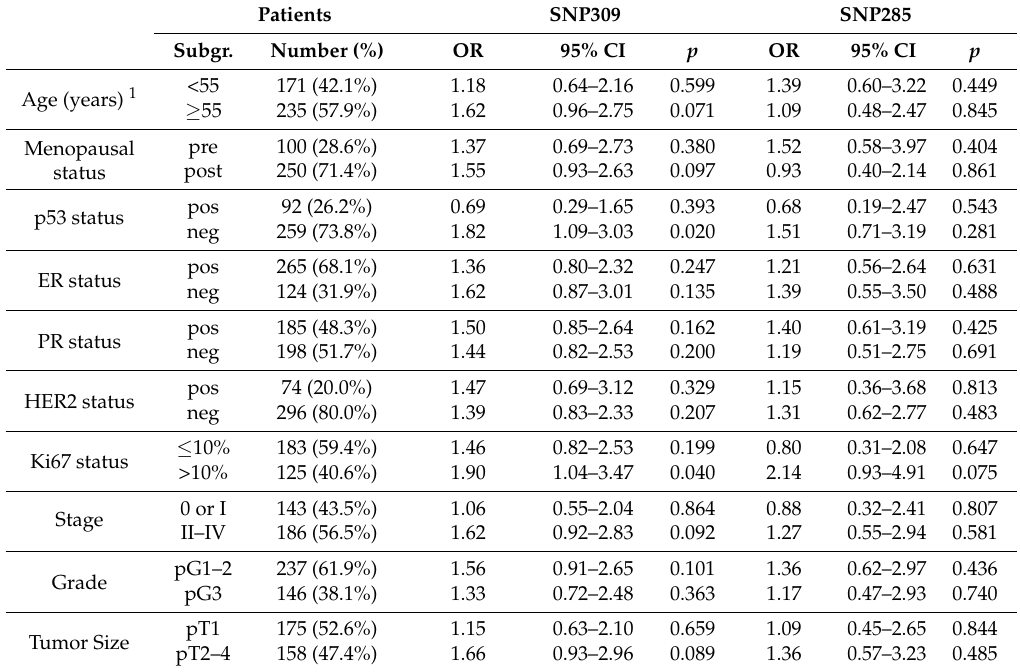
Table 3. Association of MDM2 SNP309 and SNP285 with breast cancer risk in patient